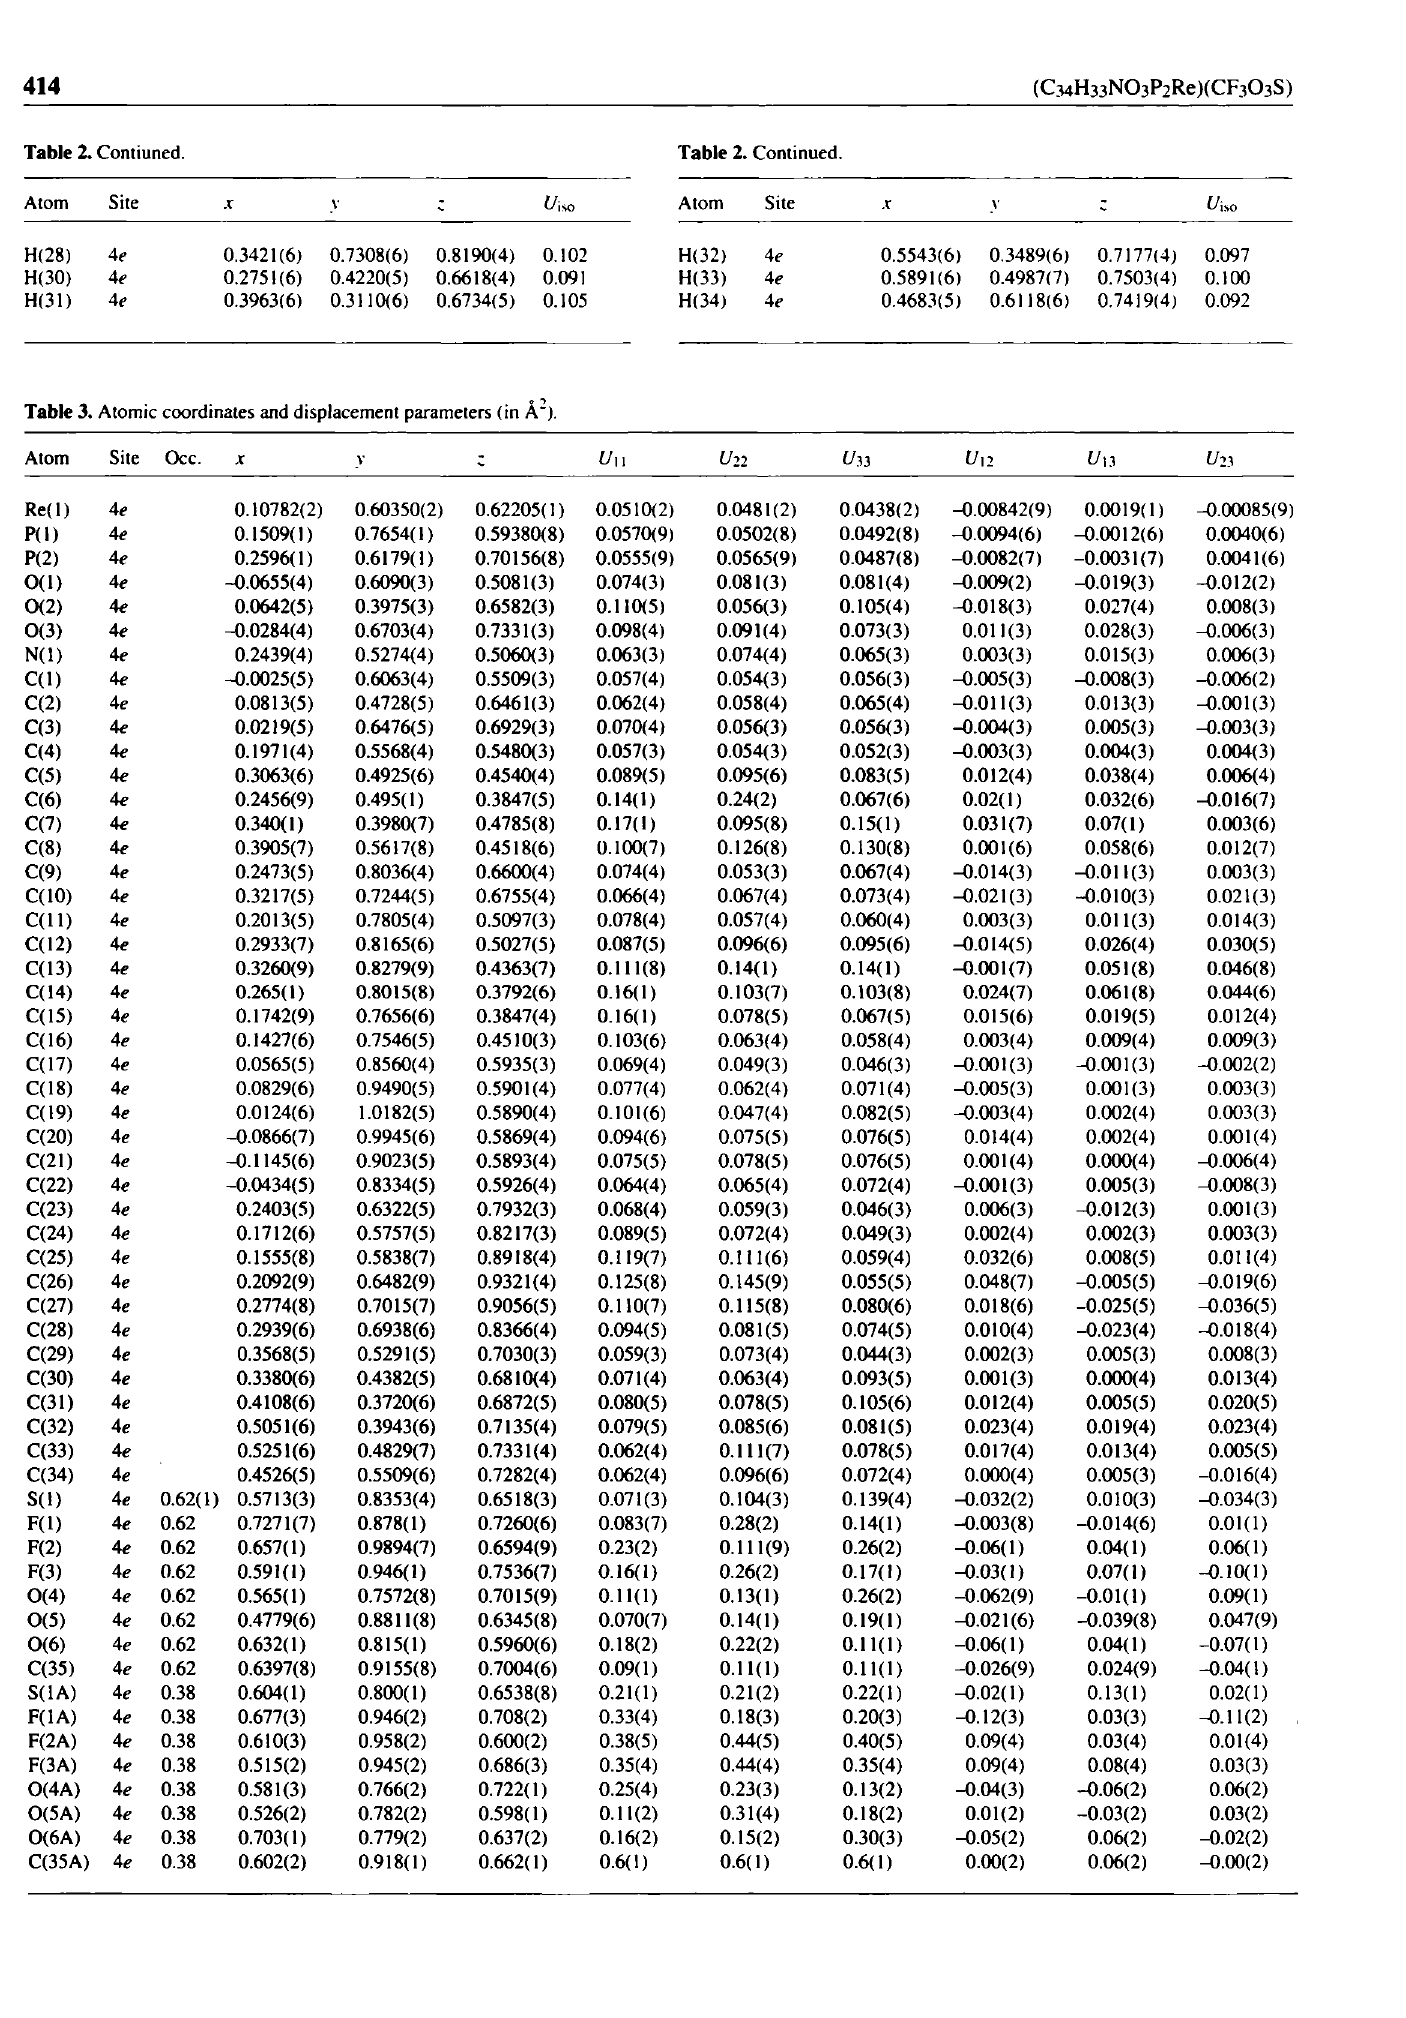
Table 3. Atomic coordinates and displacement parameters (in